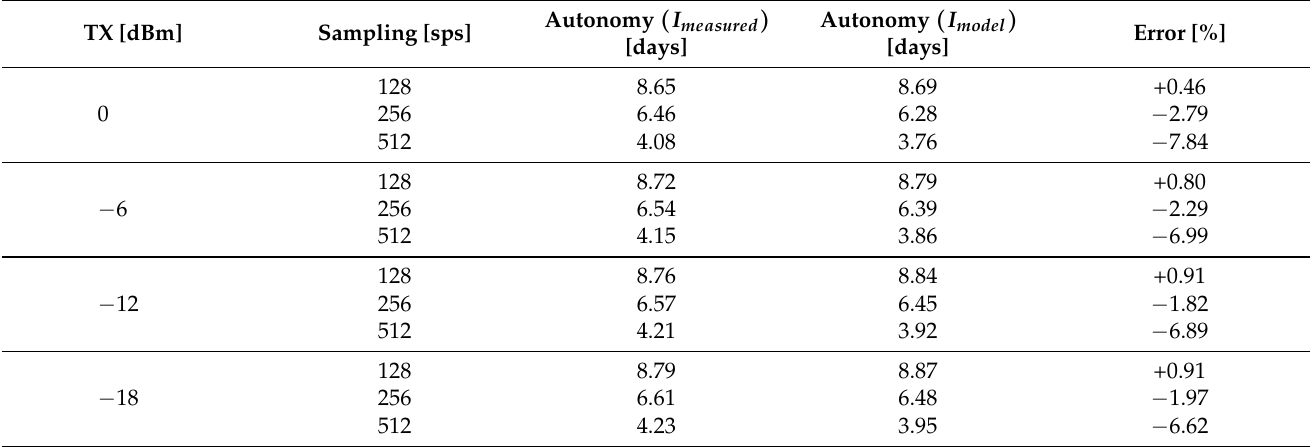
Table 6. ECG sensor autonomy estimation based on measured average current consumption and estimated model-based current consumption. Model error is expressed as percentage of the measured